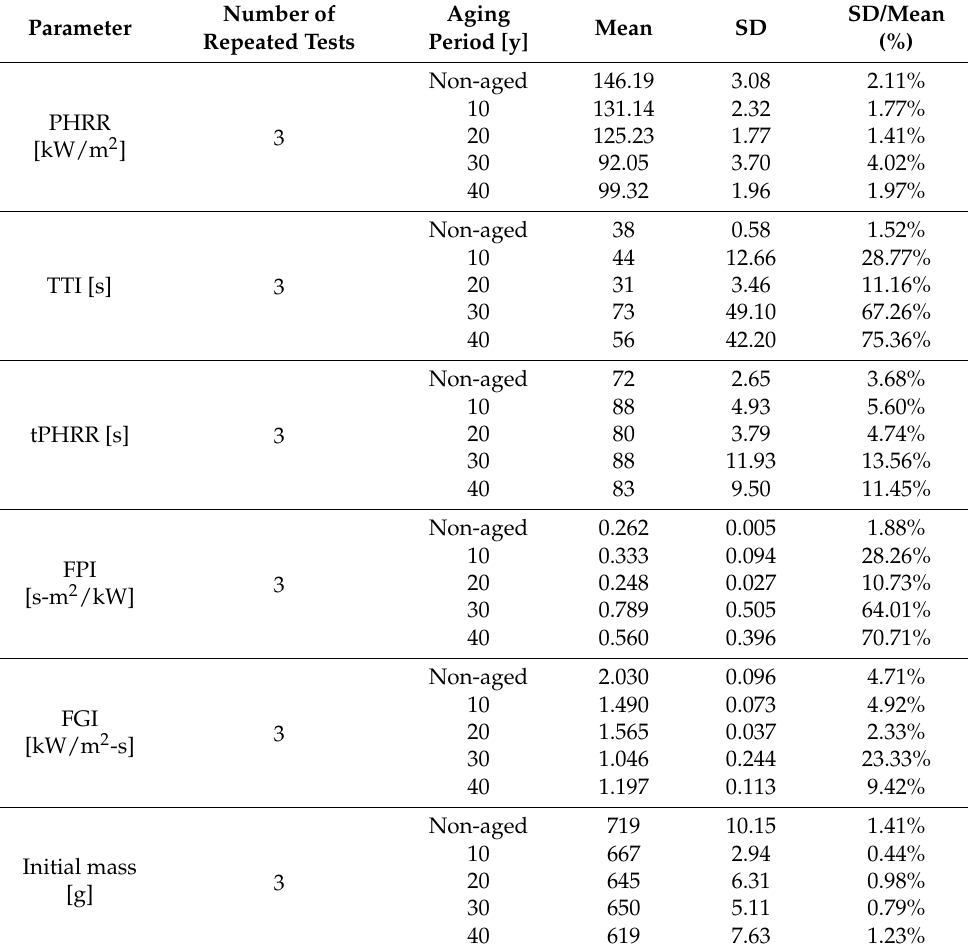
Table 4. Mean and standard deviation for each of the test